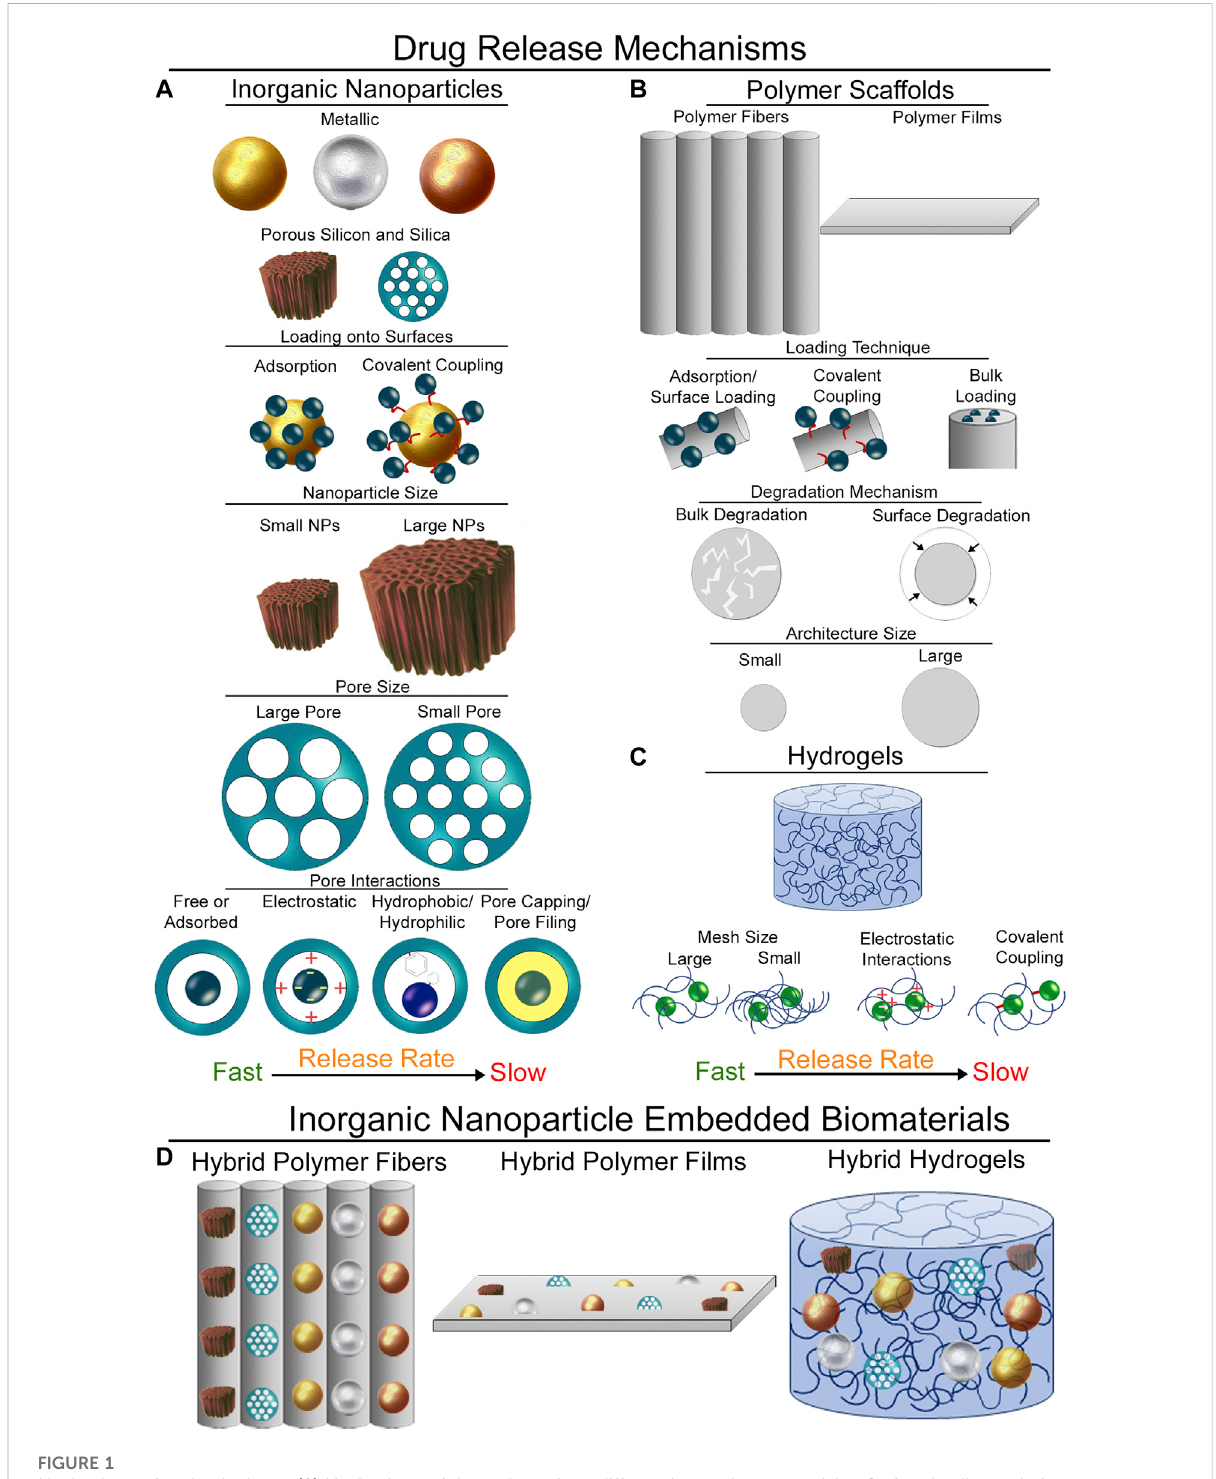
FIGURE 1 Mechanisms of payload release. (A) Mechanisms of drug release from different inorganic nanoparticles. Surface loading techniques, nanoparticle size, pore size, and pore interactions all impact the release rate of APIs from inorganic nanoparticles. (B) API release from polymer scaffolds.Loadingtechniques,degradationmechanisms ofthepolymer,andarchitecturesizeofthepolymerstructures impactpayloadreleaserate. (C) Release of APIs from hydrogels is impacted by hydrogel mesh size, electrostatic and other af fi nity-based interactions, or the ability to covalentlycoupleAPIsintothehydrogelnetwork. (D) Inorganicnanoparticlesincorporatedintobiomaterials.Thesedrugreleasemechanismscanall be combined by incorporating inorganic nanoparticles into biomaterial